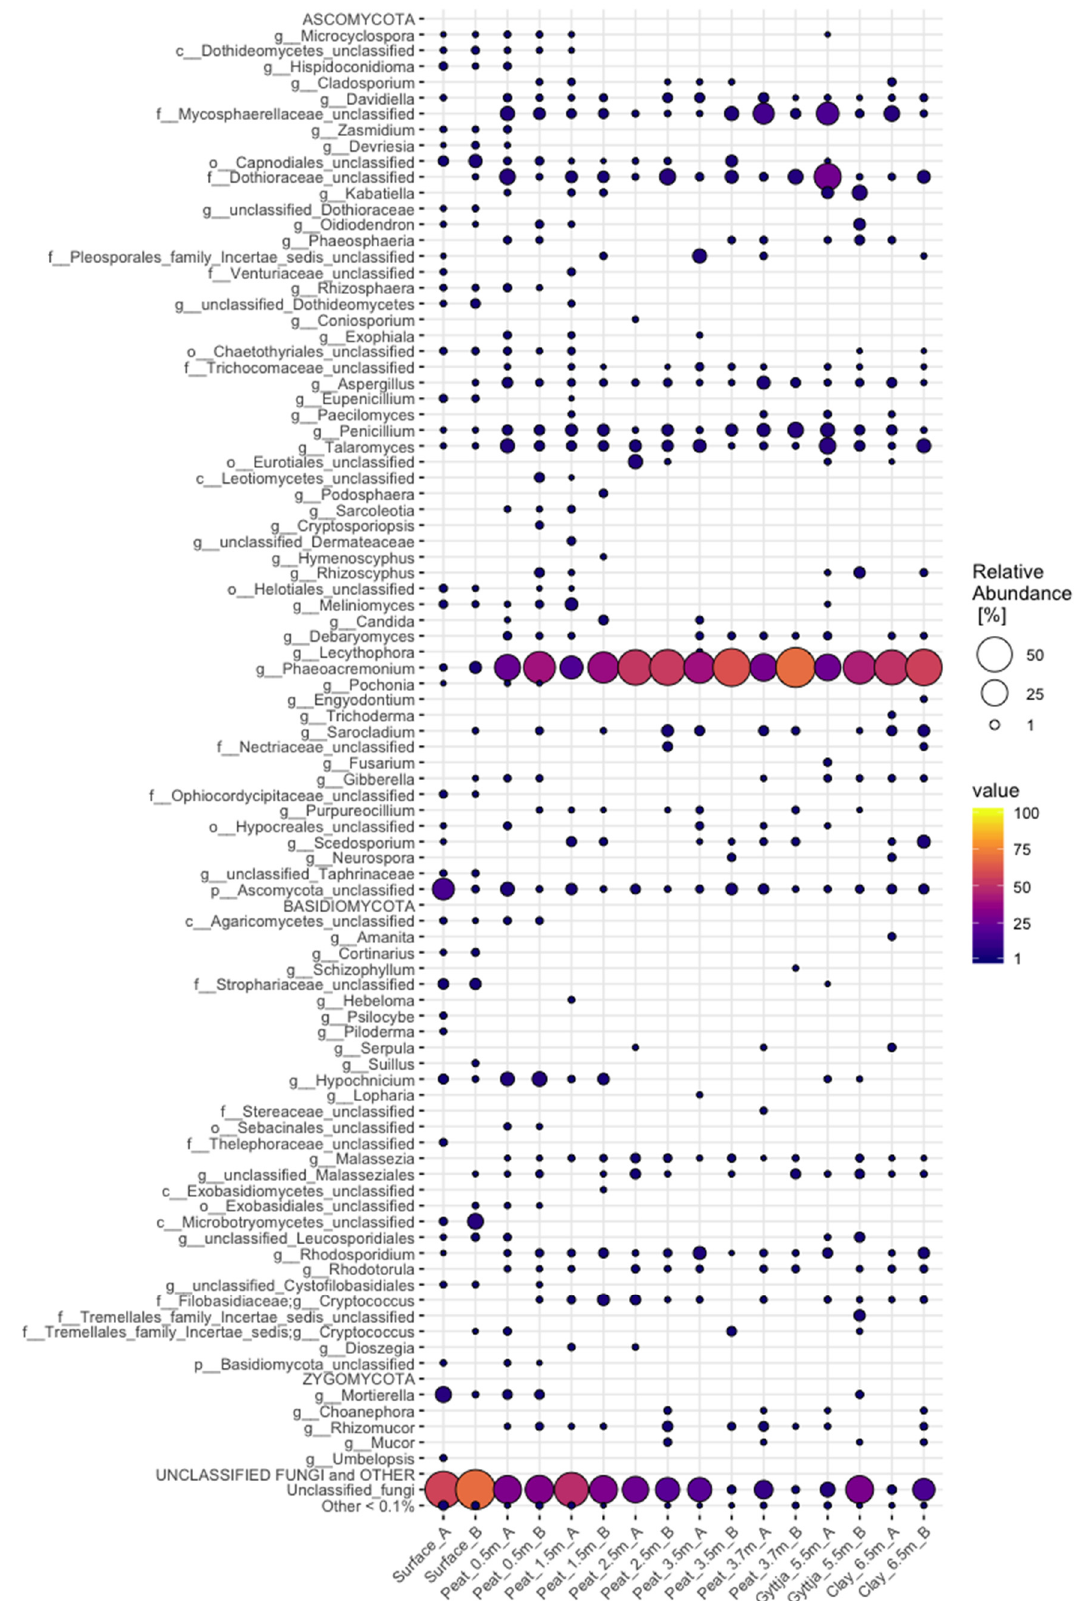
Figure A2. Relative abundance of fungal genera in surface moss, peat, gyttja, and clay samples collected from Lastensuo bog.